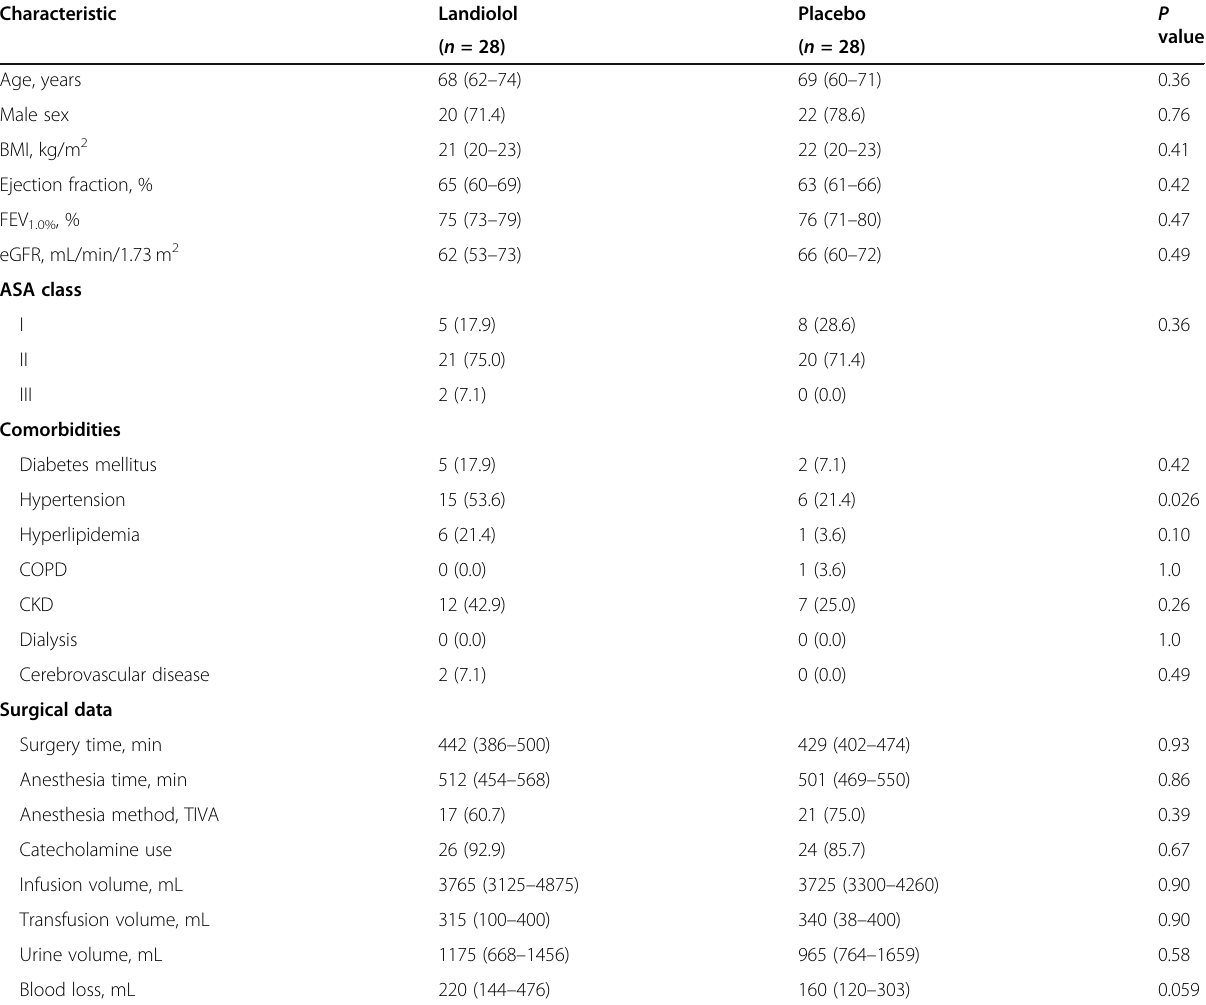
Table 1 Baseline characteristics and surgical data for patients in the landiolol and placebo groups Characteristic